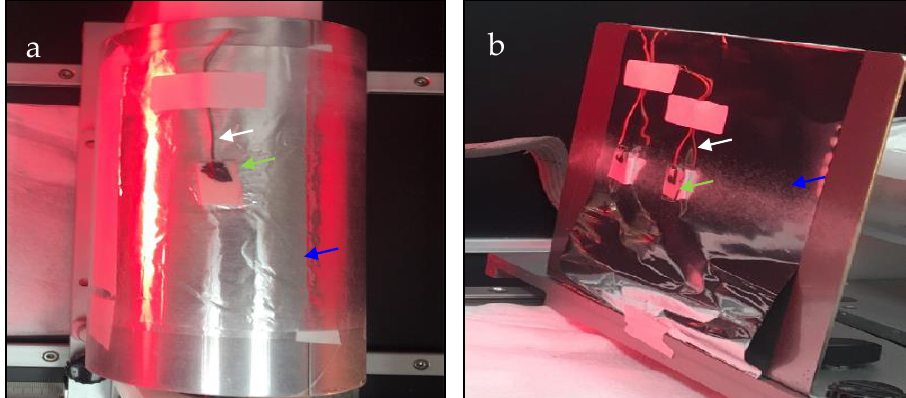
Figure 1. Optical images illustrating the preparation of chitosan–ESM on pieces of ITO substrate before the in vitro EC of CaOx glued on ( a ) rotating drum (rotation speed of 1800 rpm, clockwise) and ( b ) flat plate collectors. White, green, and blue arrows indicate working electrode, ITO glass with chitosan fibers and aluminum foil, respectively.